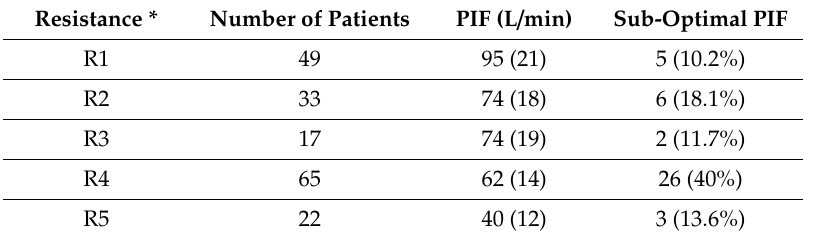
Table 2. Analysis of the mean PIF in patients with suboptimal PIF who used dry powder inhalers (DPI) as a function of the degree of resistance.